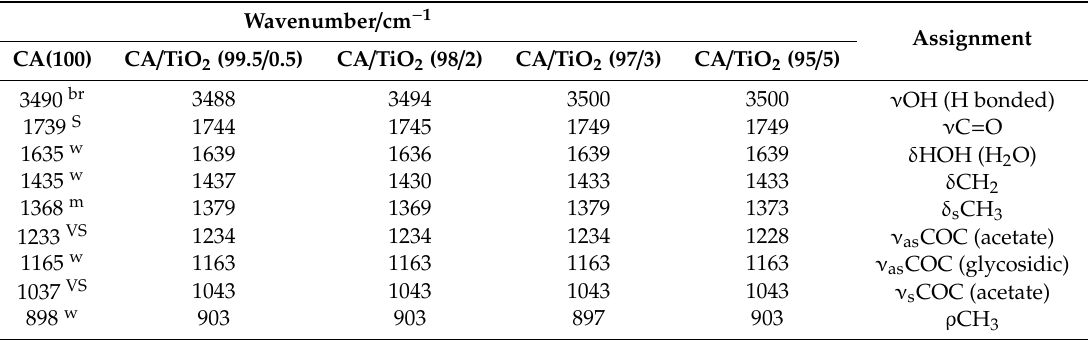
Table 6. Assignments of the ATR-FTIR spectra of the CA / TiO 2 (series 2)